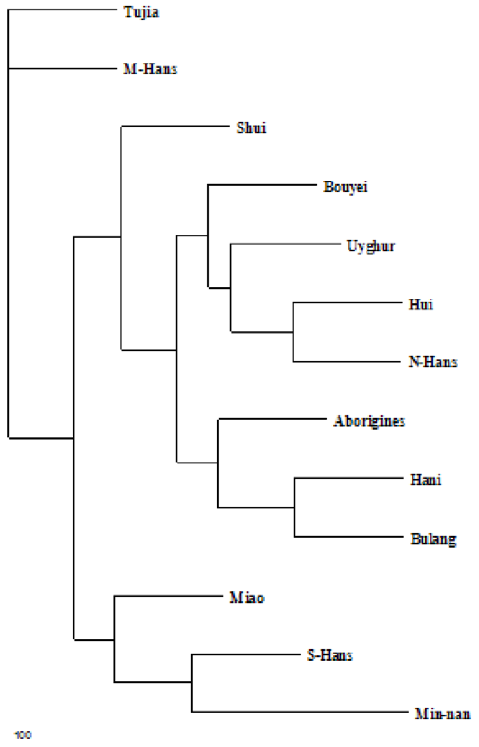
Figure 2. Phylogeny based on HLA allele frequencies. Den- droram constructed by the neighbor-joining method showing the relationship between Tujia populations in Hubei with other populations in Chinese individuals of 12 regions based on the frequencies of HLA-A loci.